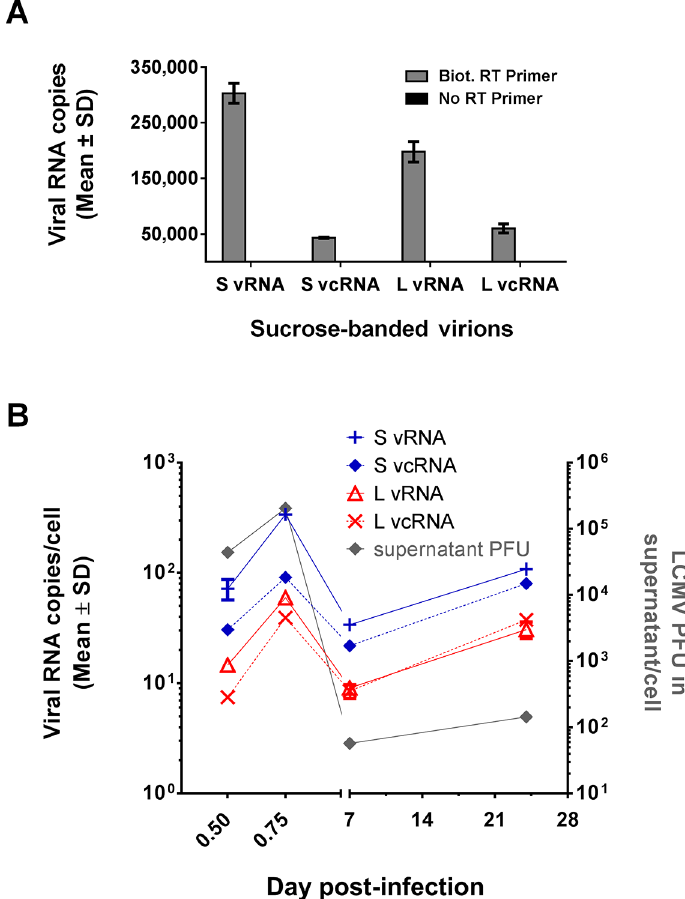
Fig 7. Use of optimized QRT-PCR assay to measure the RNA content in LCMV virions and the dynamics of genome replication during acute and persistent LCMV infection. (A) Viral RNA content of LCMV virions. RNA extracted from sucrose-banded LCMV particles collected from Vero E6 cells at 48 hr pi was subjected to RT using 9 pmol of the biotinylated RT primers listed in Table 1 (gray bars). As a control, RT was also carried out in the absence of an RT primer (black bars). Biotinylated cDNAs were affinity purified using 10 μ l of magnetic streptavidin beads and subjected to QPCR using the primer-probe sets for the vRNAs or vcRNAs of the L or S segment that are listed in Table 3. Data are presented as mean ± SD. (B) Dynamics of LCMV replication during acute and persistent LCMV infection. Viral RNA extracted from MC57 cells at 12 h, 18 hr, 7 d, or 24 d pi with LCMV was subjected to RT using 9 pmol of the biotinylated RT primers listed in Table 1. Biotinylated cDNAs were affinity purified using 10 μ l of magnetic streptavidin beads and subjected to QPCR using the primer-probe sets for S vRNA or L vRNA, respectively, that are listed in Table 3. Values are listed as mean copies per cell ± SD and are plotted on the left Y axis. For each sample, PFUs in the supernatants were determined by plaque assay and are reported as PFU/cell on the right Y